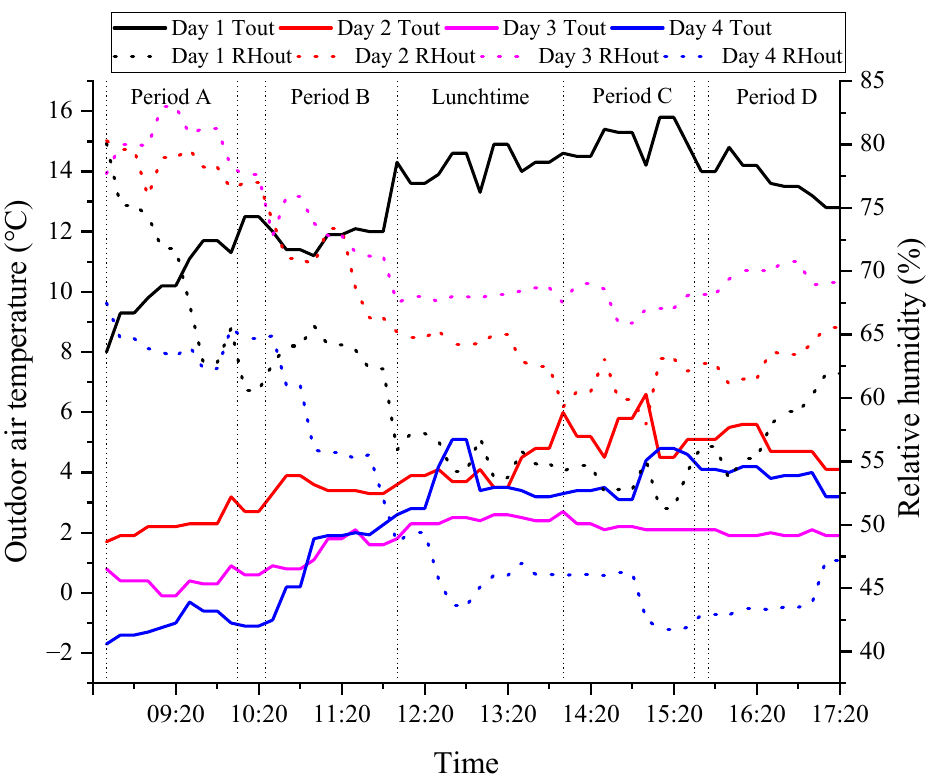
Figure 6. Outdoor air temperature and relative humidity.